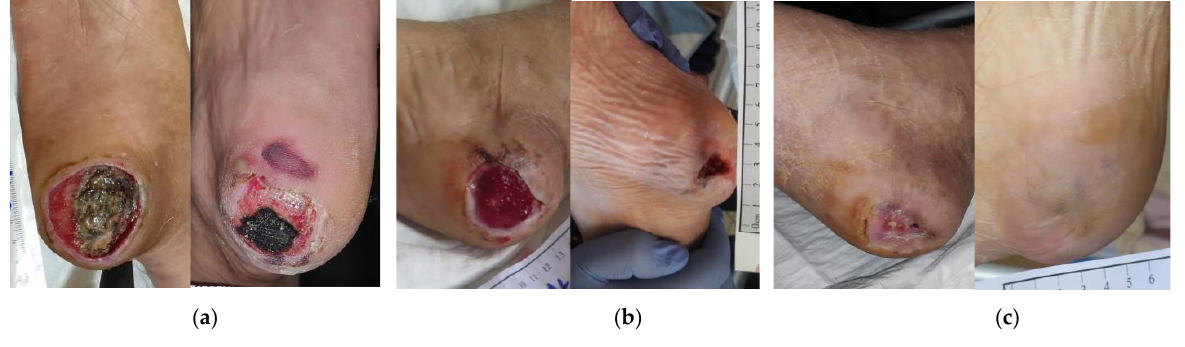
Figure 7. Case 7: ( a ) clinical findings at the initial examination, day 0 (start of MGH treatment); ( b ) MGH effectively induced autolytic debridement, resolution of the local signs of infection, and advanced wound healing after 2 weeks of treatment; ( c ) complete wound healing after 108 days of MGH therapy for the right heel and 17 weeks of MGH therapy for the left heel.